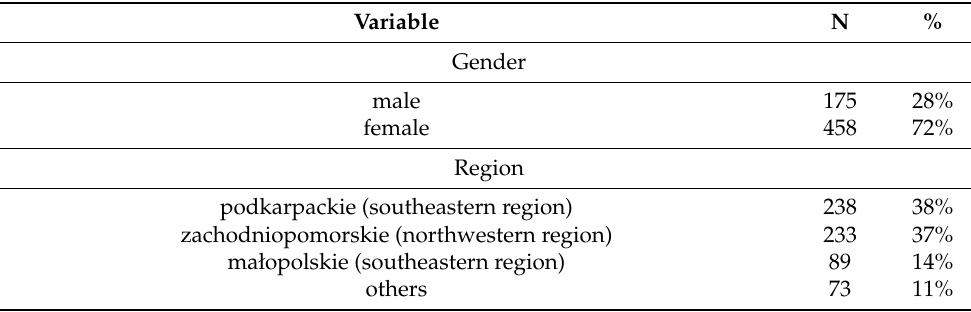
Table 2. Summary of survey